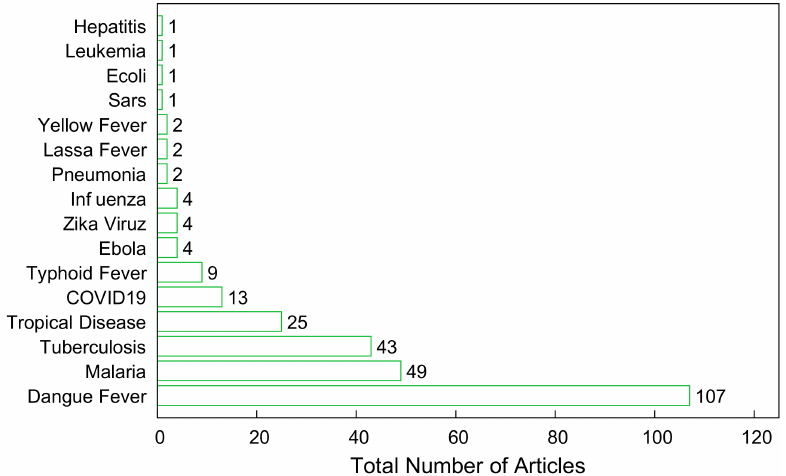
Figure 5. Frequency of diseases reported in the